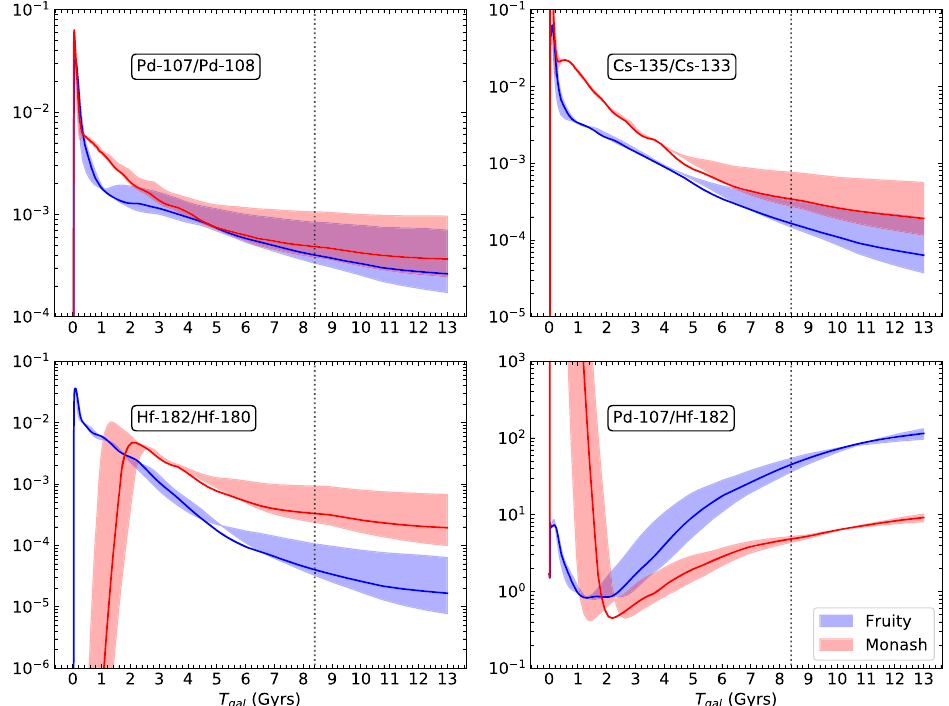
Figure3. Evolutionofthe 107 Pd / 108 Pd, 135 Cs / 133 Cs, 182 Hf / 180 Hf,and 107 Pd / 182 HfabundanceratiosintheISMasafunctionofGalactictimeusingMonash ( red ) and Figure 5. Previously published as Figure 3 in [60], ©AAS, reproduced with permission. Time- FRUITY ( blue ) ABG stellar yields. For each set of yields, the best ( solid line ) , and high and low ( extremities of the shaded region ) GCE setups are plotted. The vertical dashed line is at t e = 8.4 Gyr. The ratios do not include the r -process residual for the stable isotope since the residual is calculated only at t e . evolution predictions from our OMEGA+ GCE framework for the Milky Way of the SLR isotopes produced by AGB stars, relative to their stable reference isotope (the two top and the bottom left panel). These panels are the realisation of the bottom right panel of Figure 3 for the three specific isotopes, where the solid line is the best fit GCE and the colored bands represent the minimum and maximum models, derived using the Fruity (blue) and the Monash (red) yields. The bottom right panel represents the evolution of the ratio of the two SLR isotopes 107 Pd/ 182 Hf, for which we found the uncertainties from the stochastic Monte Carlo framework to be minimal. The dotted vertical line represents the time of the formation of the Sun and we decayed the values of the ratios at that time to their corresponding ESS values to calculate the isolation